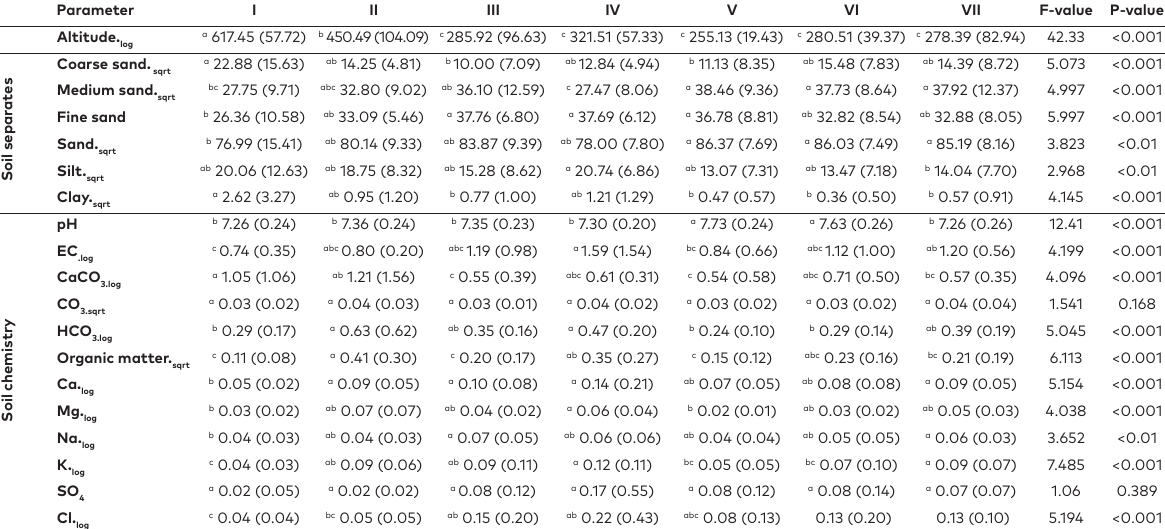
Table 3. Means and standard deviations for elevation and soil properties of the seven communities (I–VII). ANOVA test is for original, sqrt, or log data values, where values are not normally distributed. F-value and P-value refer to the ANOVA. Small letters denote the statistically different groups as identified by ANOVA post-hoc